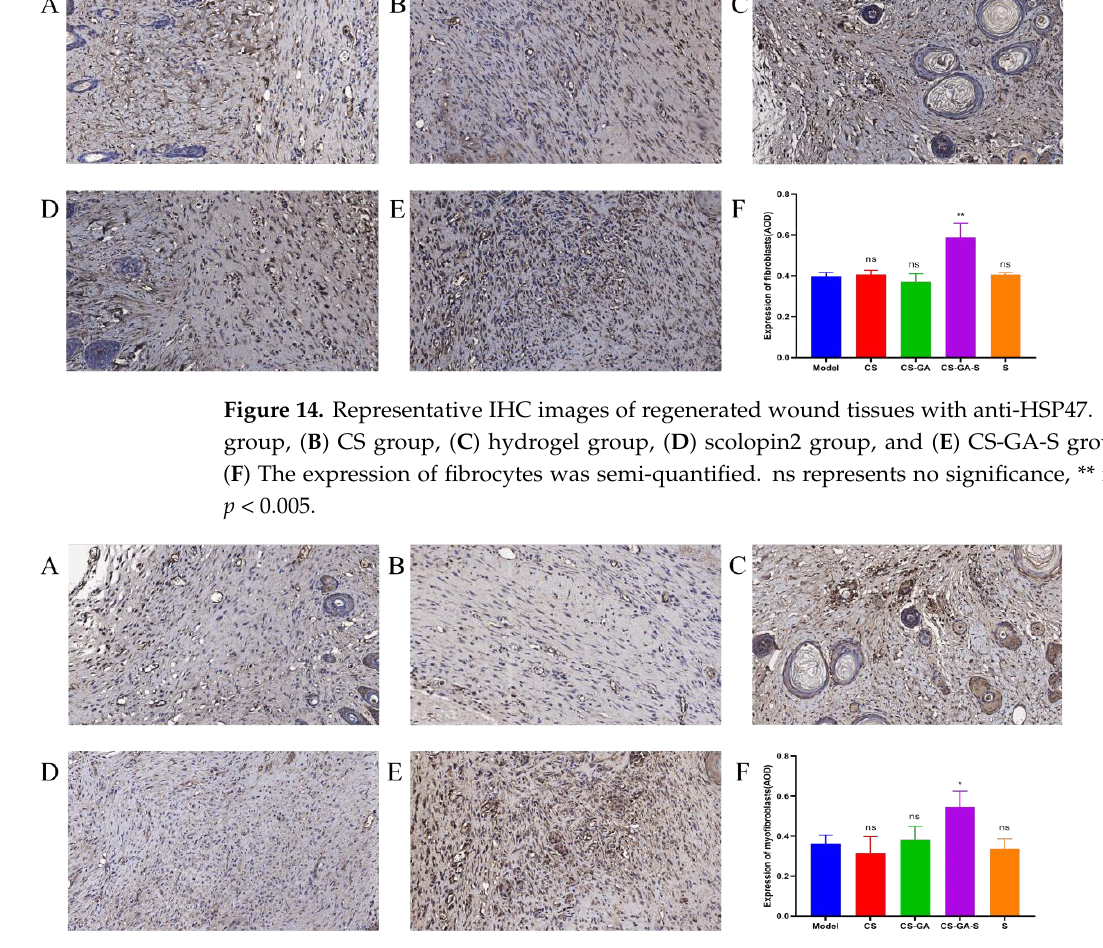
Figure 15. Representative IHC images of regenerated wound tissues with anti- α -SMA. ( A ) Model group, ( B ) CS group, ( C ) hydrogel group, ( D ) scolopin2 group, and ( E ) CS-GA-S group (×600). ( F ) The expression of myofibroblasts was semi-quantified. ns represents no significance, * represents p < 0.05.